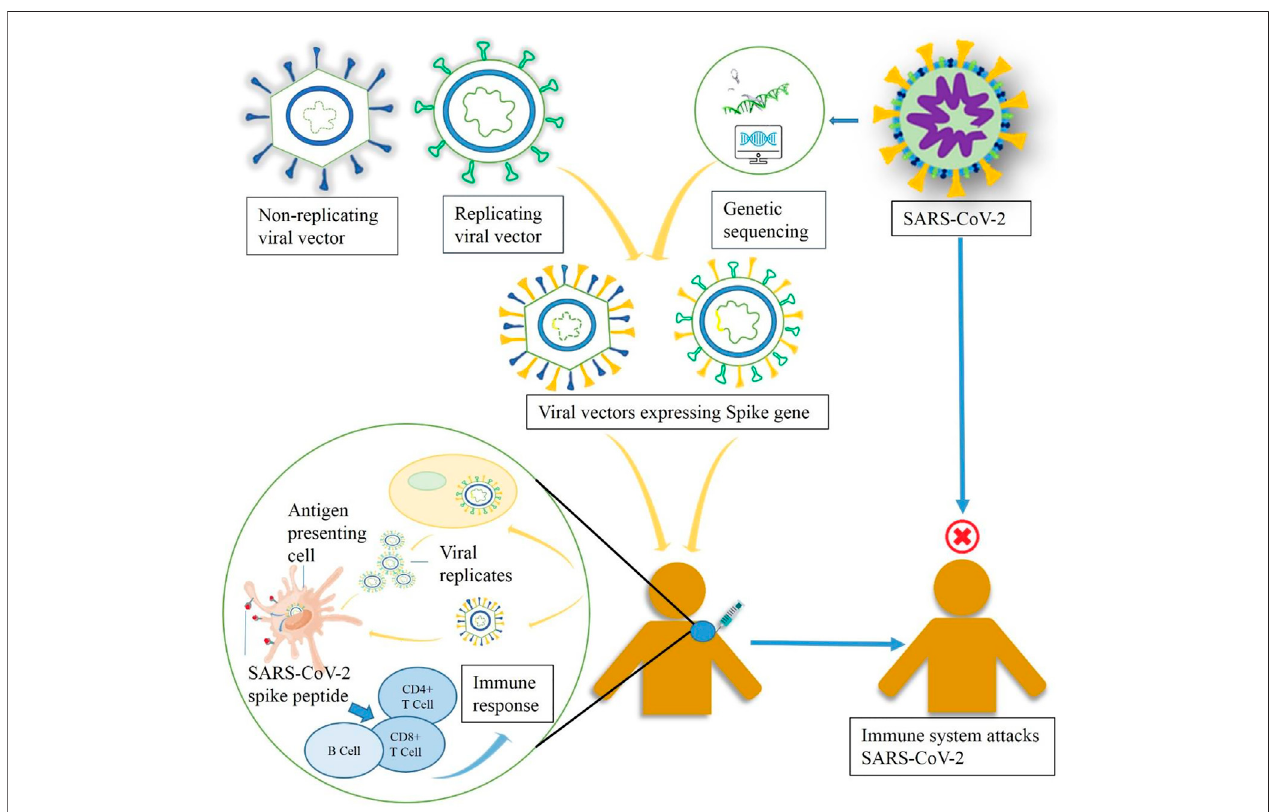
FIGURE 1 | A schematic diagram representing the working principle of replicating and nonreplicating viral vector – based vaccine candidates expressing the spike protein of SARS-CoV-2.